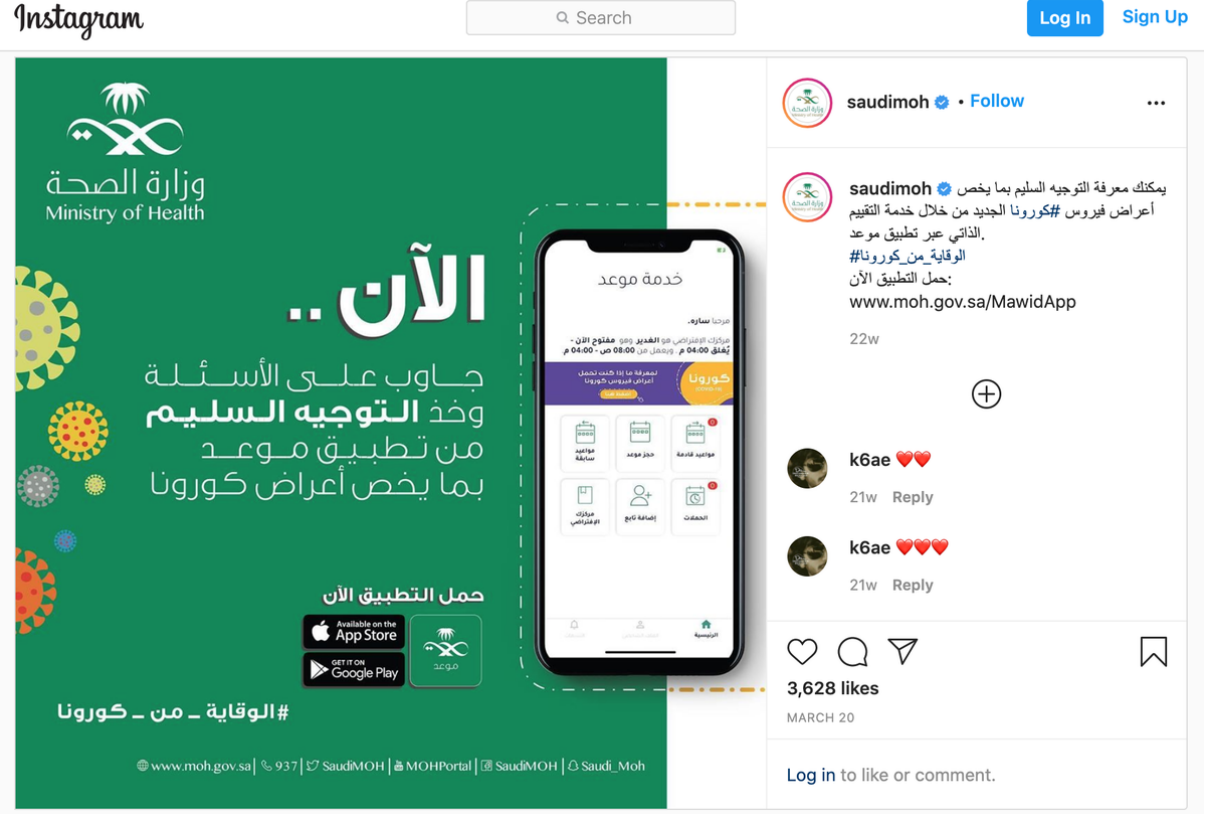
Figure 2. Instagram advertisement for the new symptom checker feature on the Saudi Ministry of Heath’s scheduling mobile app.